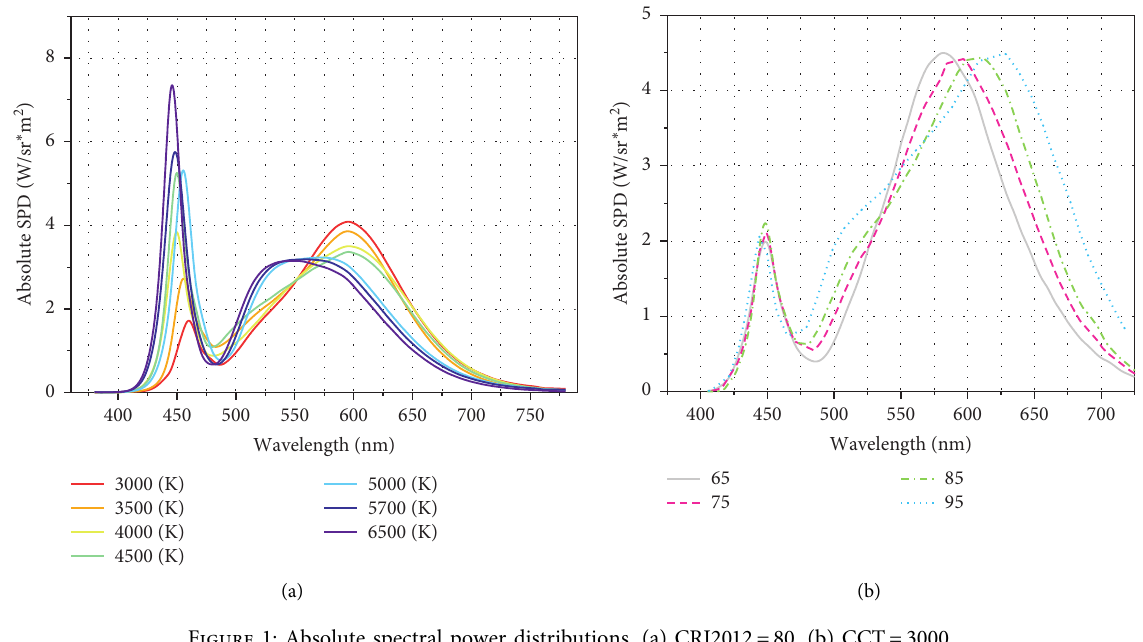
Figure 1: Absolute spectral power distributions. (a) CRI2012 � 80. (b) CCT �